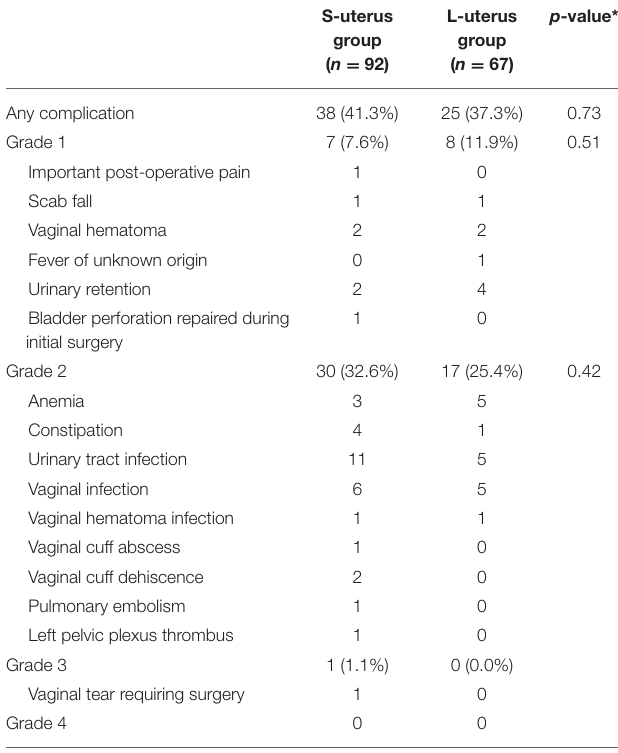
TABLE 3 | Details of complications according to Clavien–Dindo